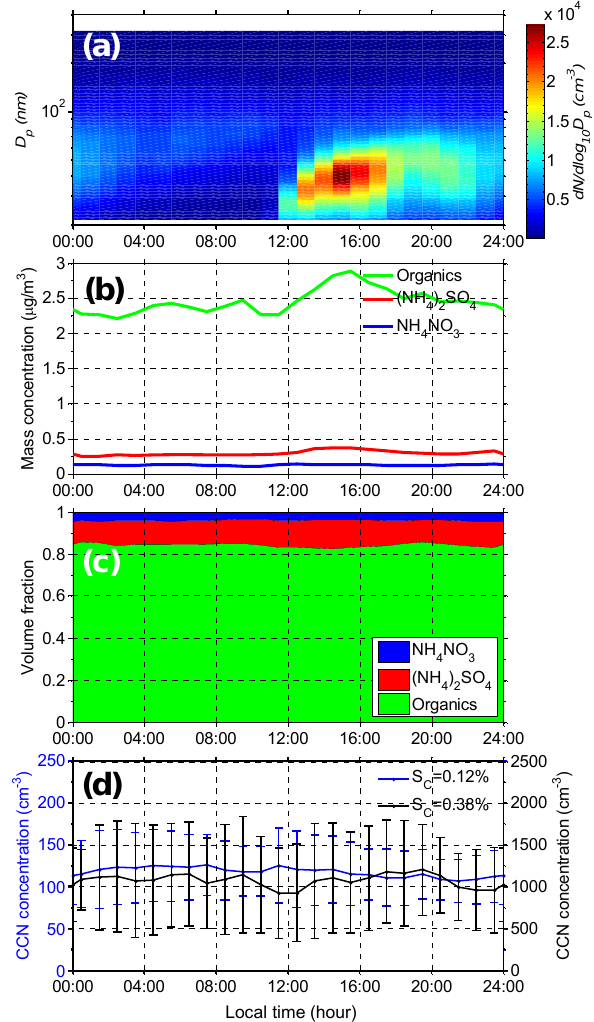
Fig. 1. Diurnal variations of aerosol properties observed at the T1 site from 10 June to 28 June 2012. (a) Aerosol size distribu- tion; (b) mass concentrations and (c) volume fractions of organics, (NH 4 ) 2 SO 4 , and NH 4 NO 3 ; and (d) CCN concentrations measured at supersaturations of 0.12% and